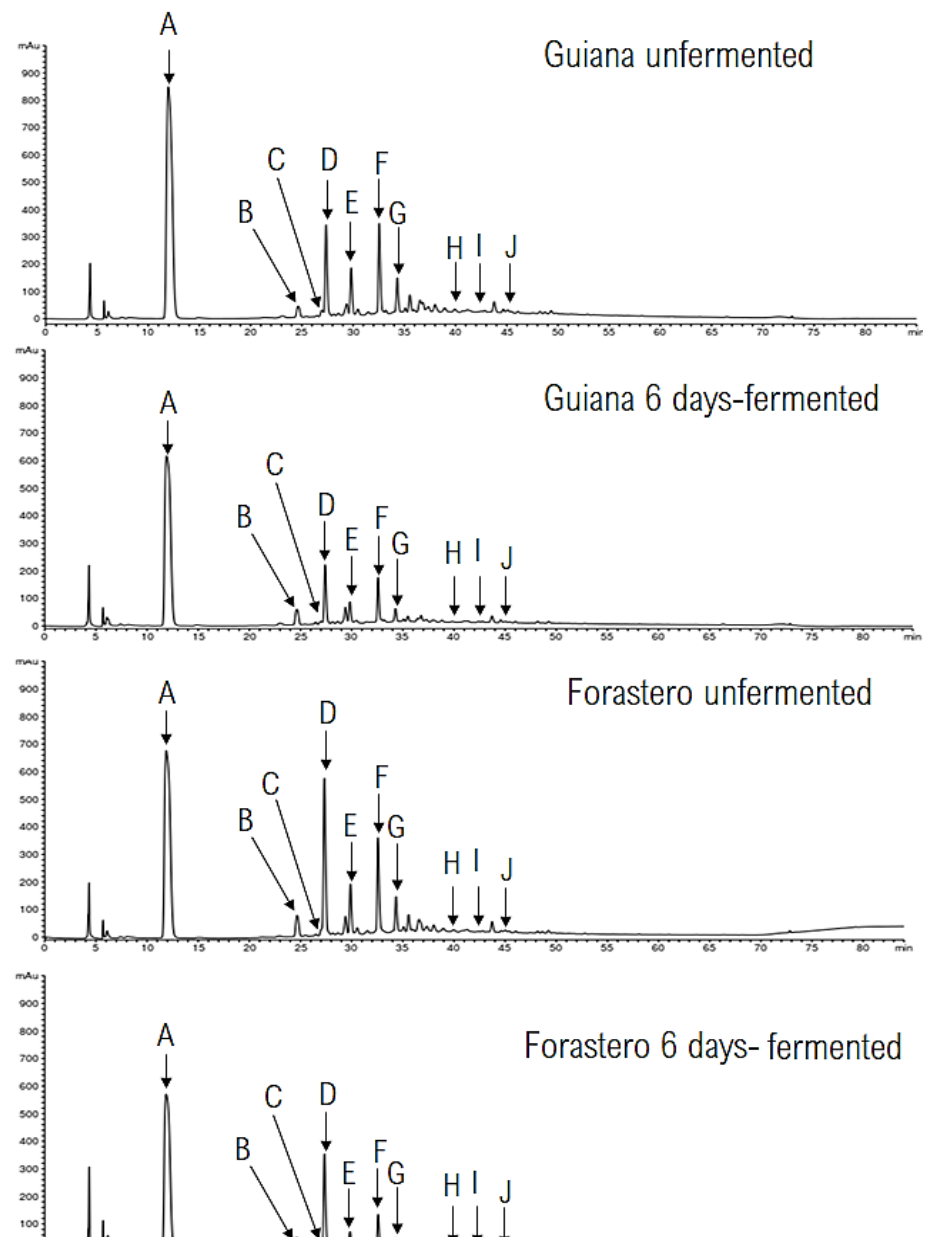
Figure 1. Liquid chromatography chromatograms of Guiana and Forastero 2018 extracts (unfermented and fermented for six days). A: Theobromine, B: Procyanidin B3 + unknown compound, C: Catechin, D: Caffeine, E: Procyanidin B2, F: Epicatechin, G: Procyanidin C1, H: Procyanidin A1, I: Epicatechin gallate, J: Procyanidin